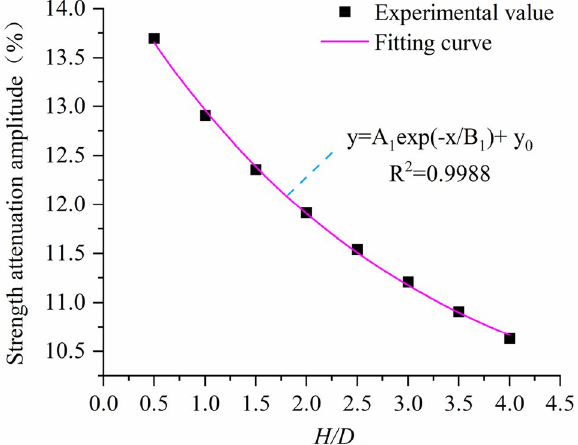
Figure 16. Curve of decreasing range of uniaxial compressive